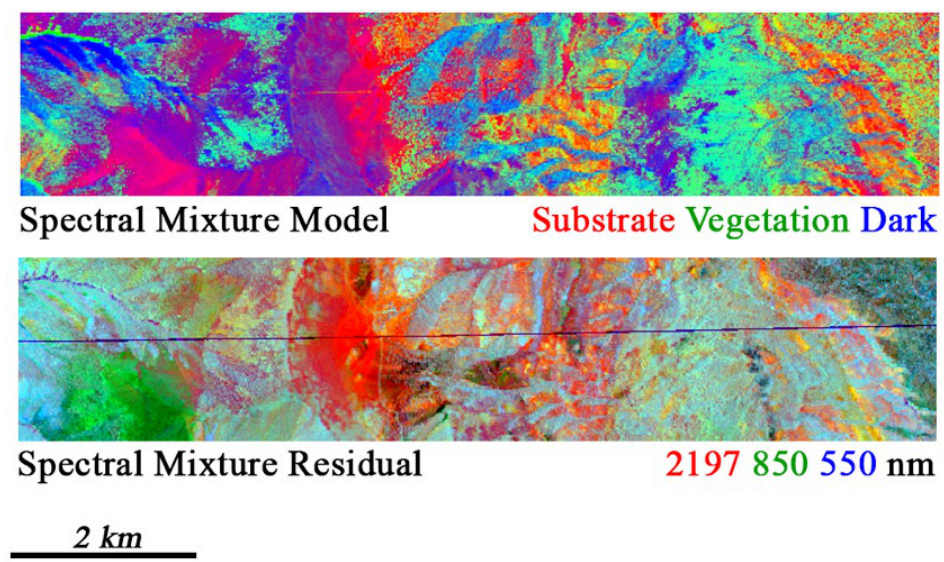
Figure 5. ( Top ) Spectral mixture model. Red: rock and soil (Substrate); green: illuminated photo- synthetic vegetation; blue: albedo, illumination, and soil moisture (Dark). The spectral contribution of each generic component is modeled and removed. The unmodeled remainder of the spectral information is retained in the mixture residual and used for subsequent analysis. ( Bottom ) Spectral mixture residual. False color composite shows spatial variability in wavelength-dependent mixture model misfit. Variability within and among mapped geologic units is evident in the mixture residual that is not clearly expressed in the reflectance (Figure 2) or in the spectral mixture model.